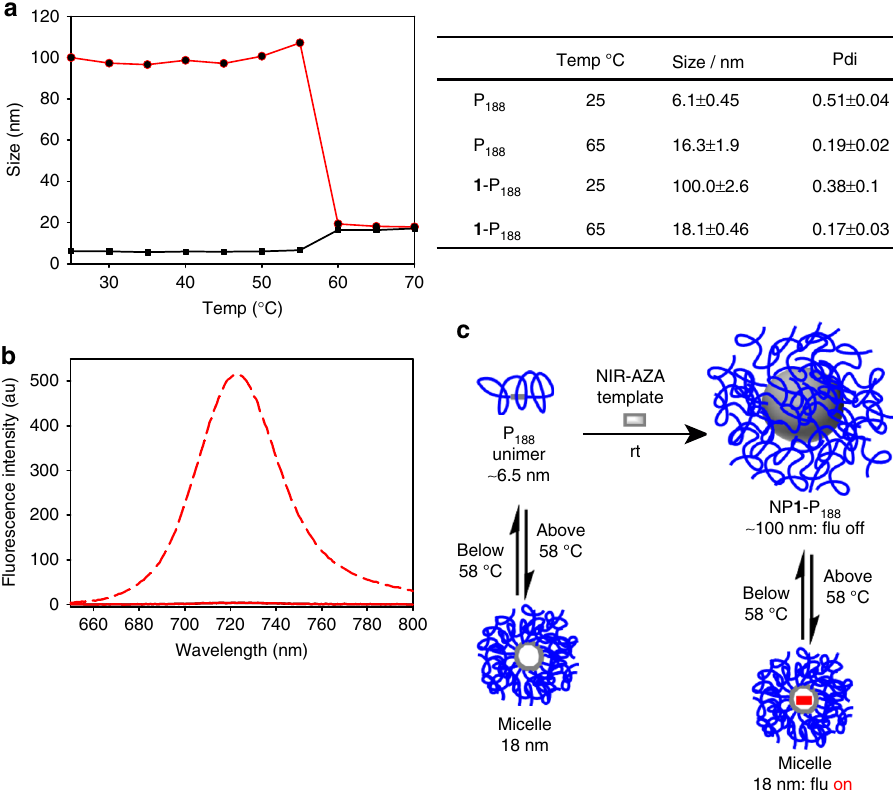
Fig. 4 Temperature responses of NP 1 -P 188 indicates involvement of hydration/dehydration in emission switching. a Plot of temperature induced size changes and dynamic light-scattering (DLS) data showing the interchange from unimer to micelle for P 188 (black trace) and from NP 1 -P 188 to micelle containing 1 (red trace) (average of three independent experiments), Polydispersity index (Pdi). Critical micelle temperatures (CMT) = 58 °C. b Temperature induced emission intensity difference for aqueous NP 1 -P 188 . Spectrum taken at 25 °C (red solid trace), 65 °C (red dashed trace). Fluorescence enhancement factor (FEF) determined by peak area. Conc. 5 µ M 1 ; 1.19 mM P 188 . c Schematic summary of temperature induced responses